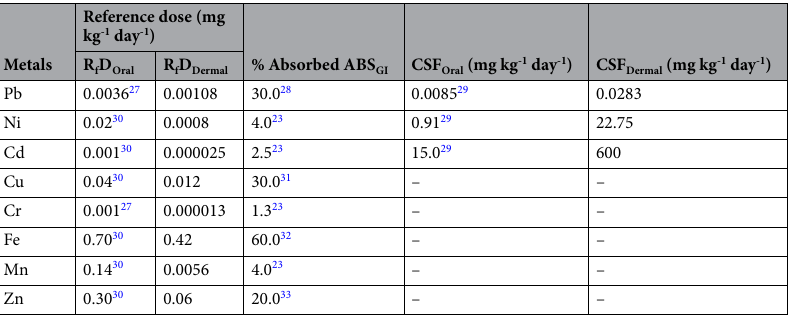
Table 3. Oral and dermal reference doses (R f D Oral and R f D Dermal ) for different trace elements along with cancer slope factor